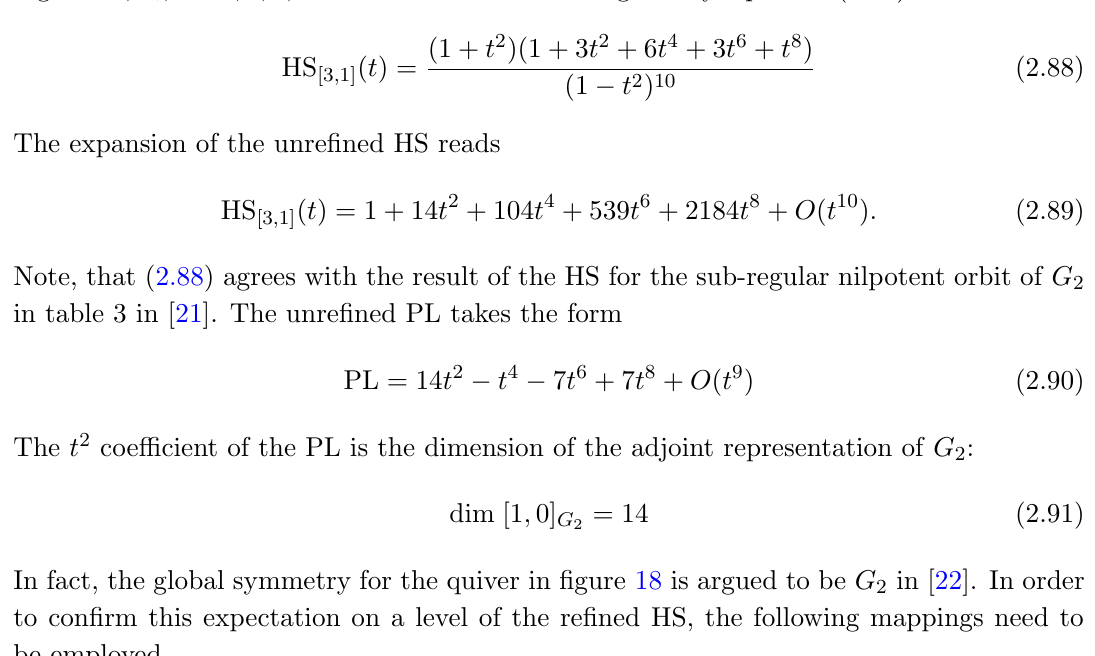
Figure 19 . A(cid:14)ne Dynkin diagram of G 2 with Coxeter labels and simple root